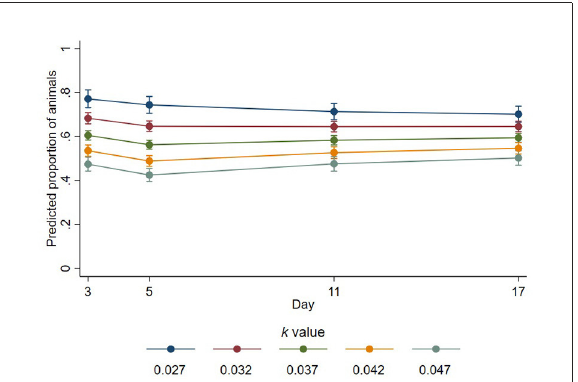
FIGURE3 Predicted proportions of animals lying with their head down that place their head on a conspecific at different k -values across days. Error bars represent 95% confidence intervals of predicted proportions. Predicted proportions were calculates as predicted numbers divided by the average number of sheep lying at each time point